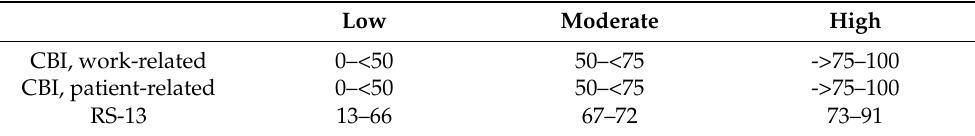
Table 1. Qualitative categorisation of the Copenhagen Burnout Inventory (CBI) and the RS-13 resilience